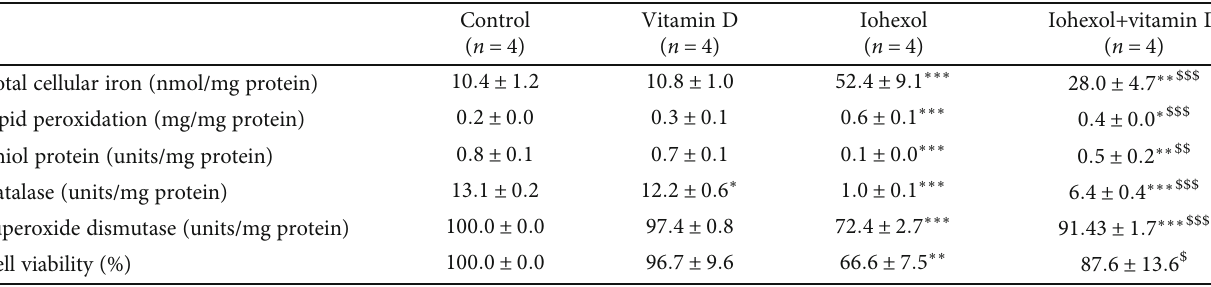
Table 1: Descriptive